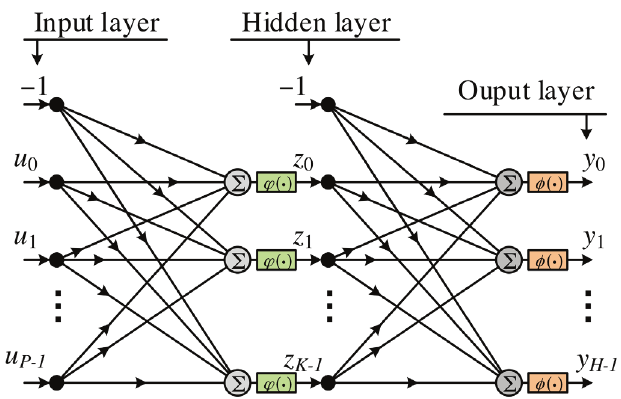
FIGURE 1 - The Multi-Layer perceptron with three-layer. The network with P neurons in the input layer, K neurons in the hidden layer, and H neurons in the output